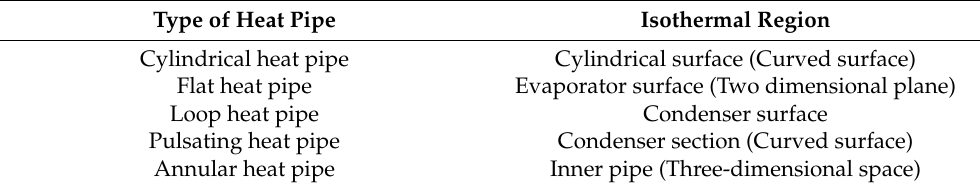
Table 1. Common types of heat pipe in isothermal